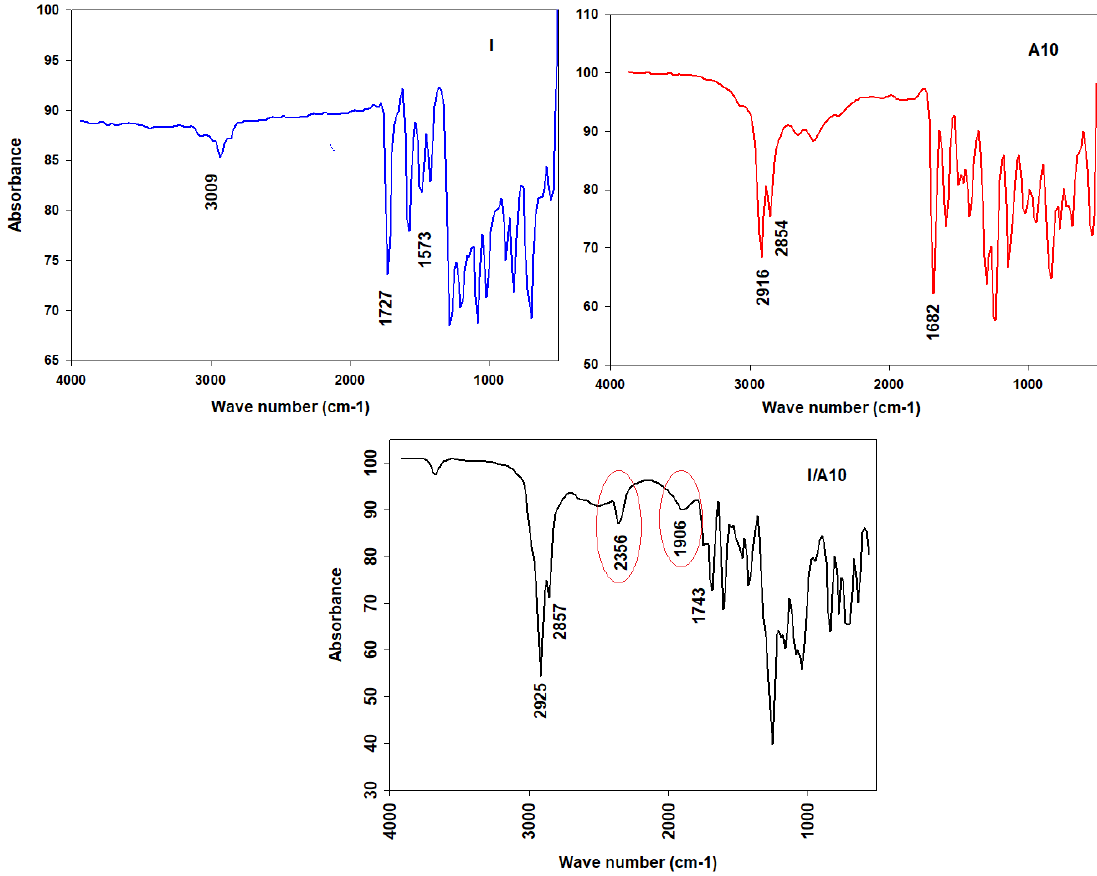
Figure 5. FT-IR spectra of I , A10 , and I / A10 .